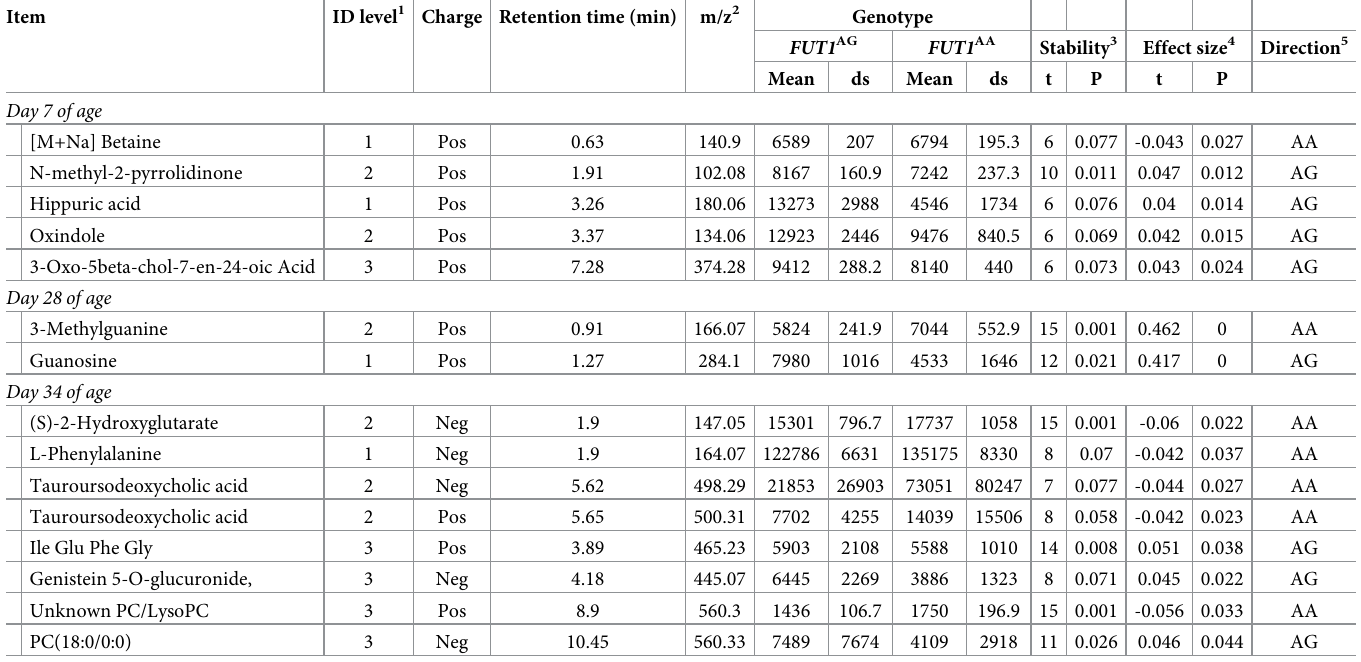
Table 1. Discriminant plasma metabolites for FUT1 AA and FUT1 AG obtained from piglets at 7, 28 and 34 days of age by the sMLPLS-DA.